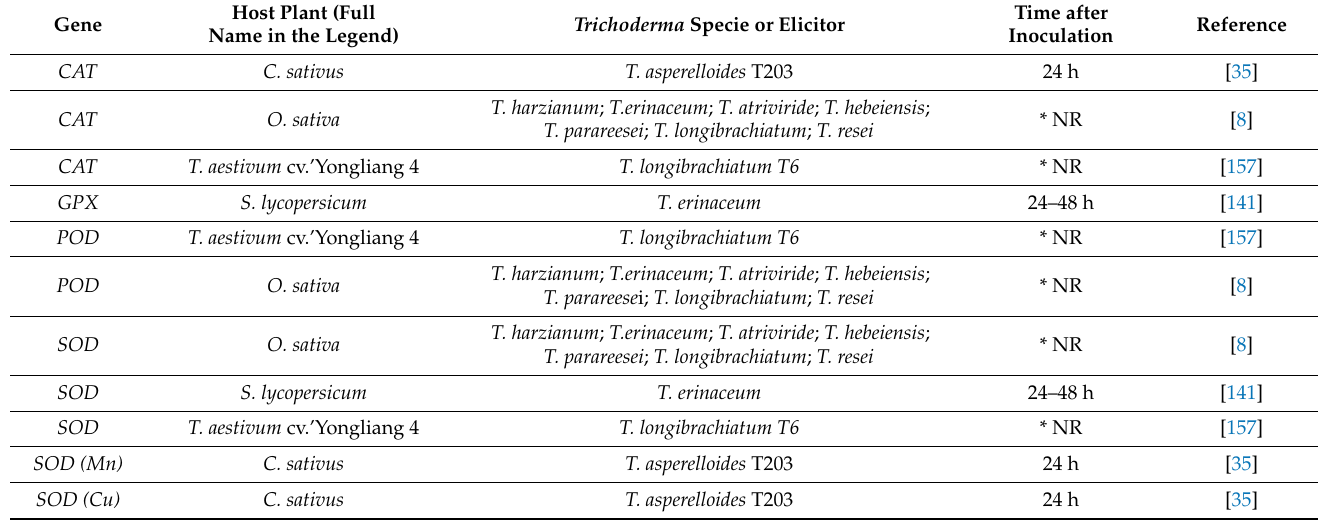
Table 4. Induction of expression of plant antioxidant genes by Trichoderma